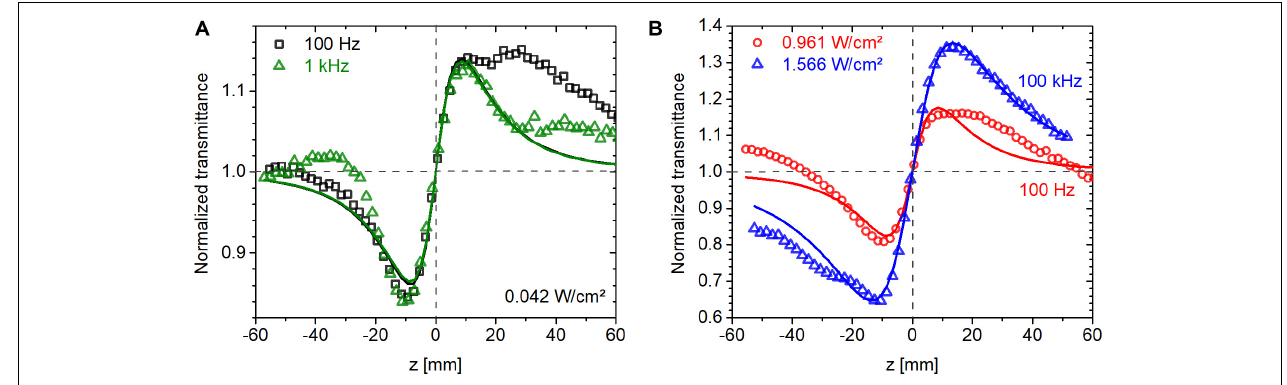
FIGURE 6 | Closed-aperture Z-scan traces measured on bR using fs laser pulses at 514 nm at average intensities of (A) 0.042 W/cm 2 and (B) around 1 W/cm 2 . The symbols are measured data points obtained at various laser repetition rates, and the lines are fitted traces based on Eq. 1.